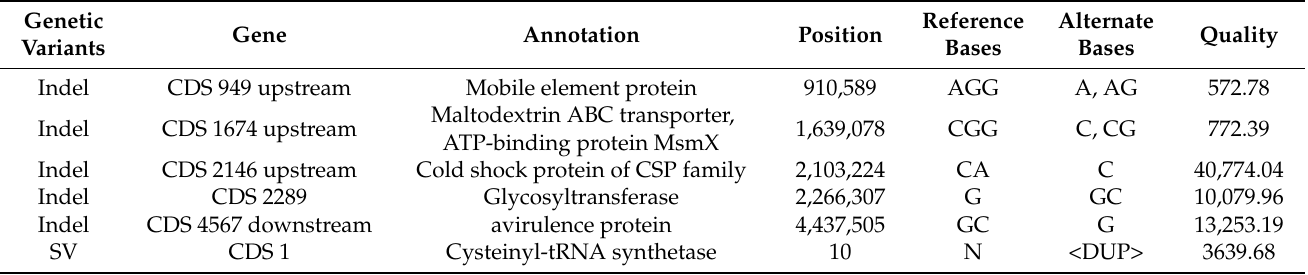
Table 3. Summary of the spontaneous mutation sites in phage-resistant mutant C2R of Xoo